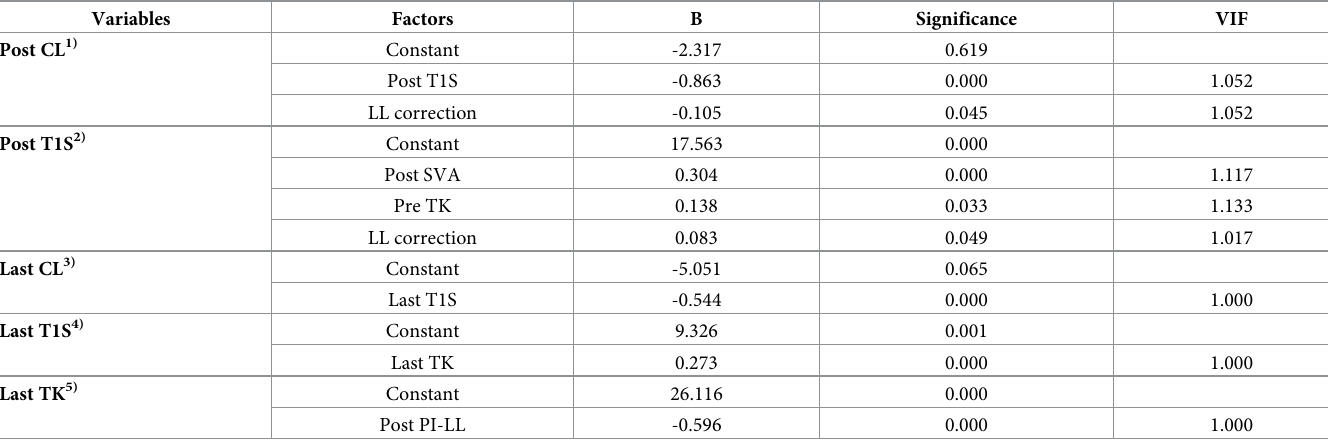
Table 4. Multilinear regression analysis.